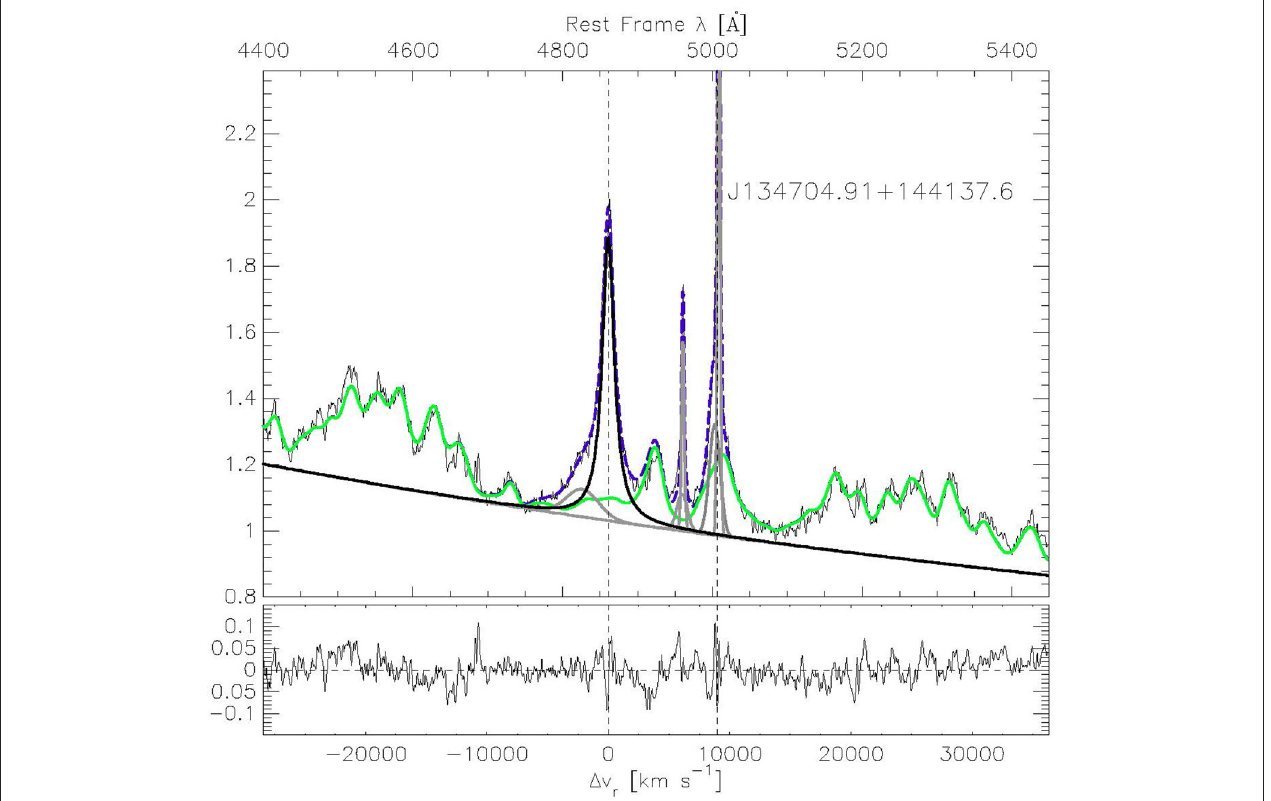
FIGURE 1 | Example of line decomposition for the quasar J134704.91 + 144137.6 using specfit . See text for description.